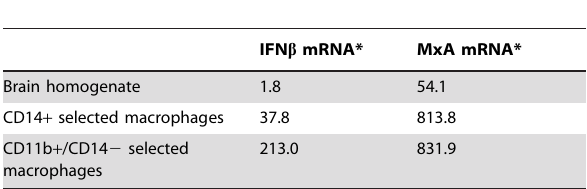
Table 2. Innate Immune Response in Brain 4 Days P.I.